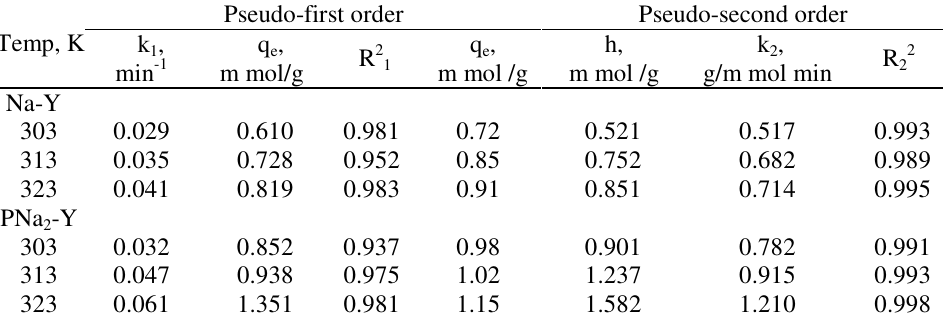
Table 3. The calculated parameters of the pseudo-first order and pseudo-second order kinetic models of Ni 2+ ions from Na-ZSM-5and PNa -ZSM-5 zeolites. 2 Pseudo-first